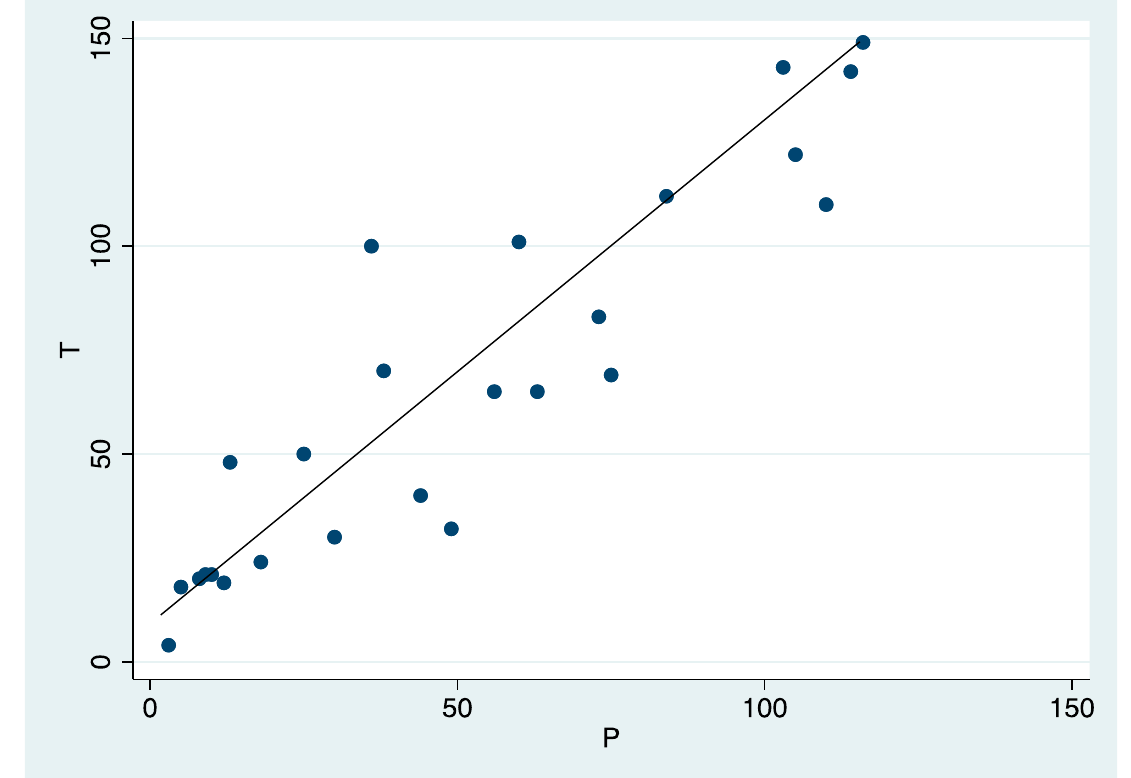
Figure 2. Scatter plot of host rankings at p and T with the regression line inserted.